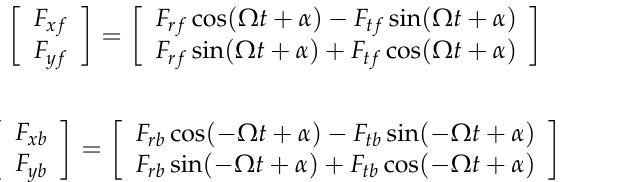
( b ) Circular orbit (Backward) Figure 6. Coordinate transformation of fluid-induced forces. In Figure 6 and Equations (13) and (14), the tangential force F t and radial forces F r are positive when they are in the same directions as the forward whirl and radial displace- ment, respectively. Conversely, the tangential force F t and radial forces F r are negative